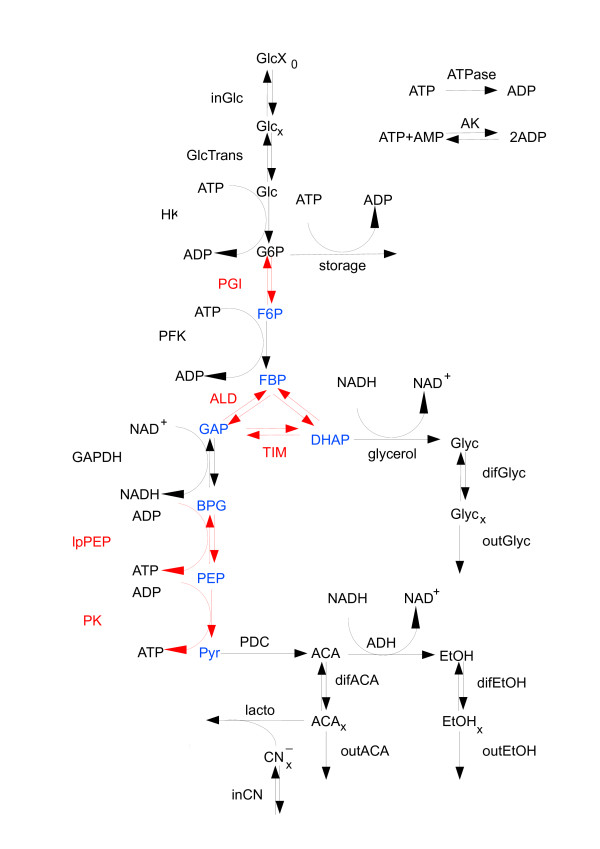
Reaction scheme for the glycolysis model of S. cerevisiae. Fast reactions are marked in red, reduced (or lumped) metabolites in blue.